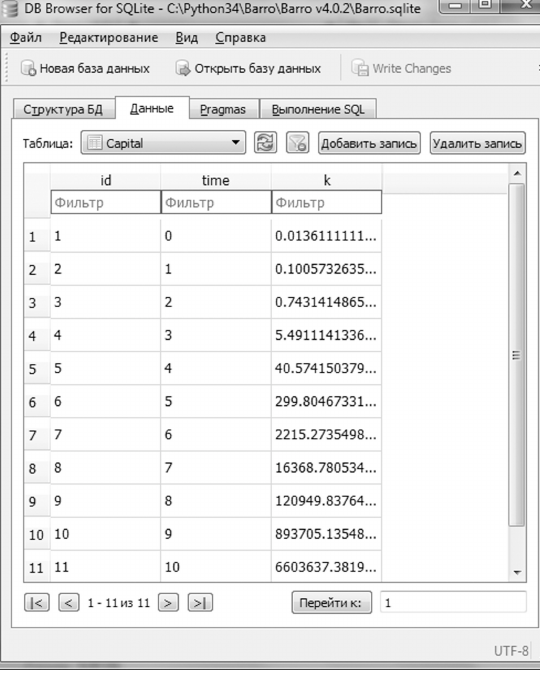
Fig. 8. The generated table in the